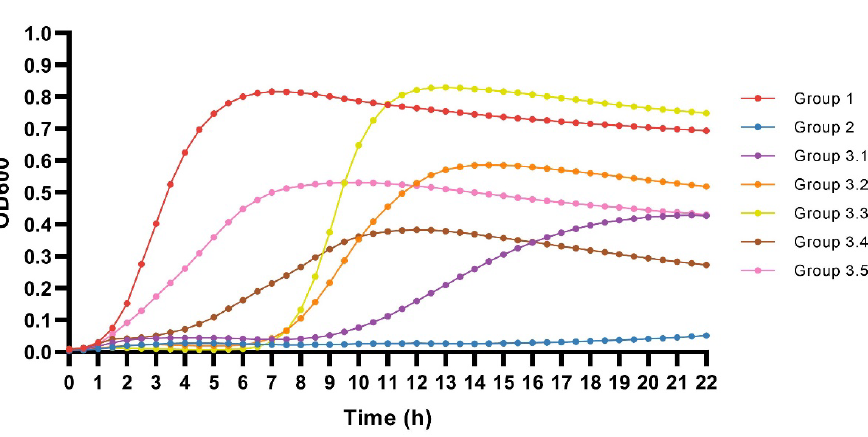
Figure 8. Growth dynamic patterns of the coliphage–APEC coculture combinations. Patterns are defined based on the average optical density (OD) value for each timepoint for each group.